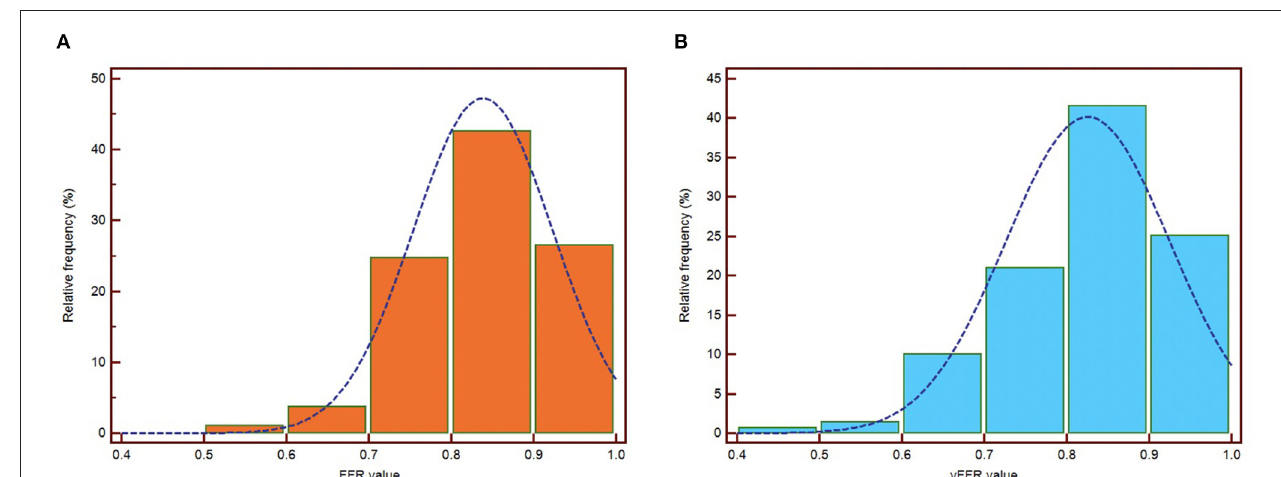
FIGURE 3 | Distribution of values for FFR (A) and vFFR (B)